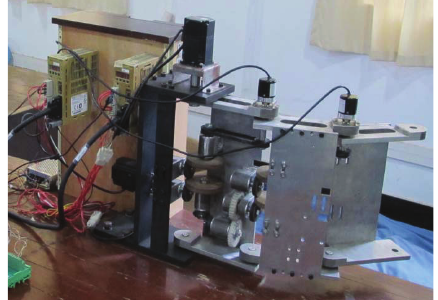
Figure 2: Prototype of three joints and two actuators.